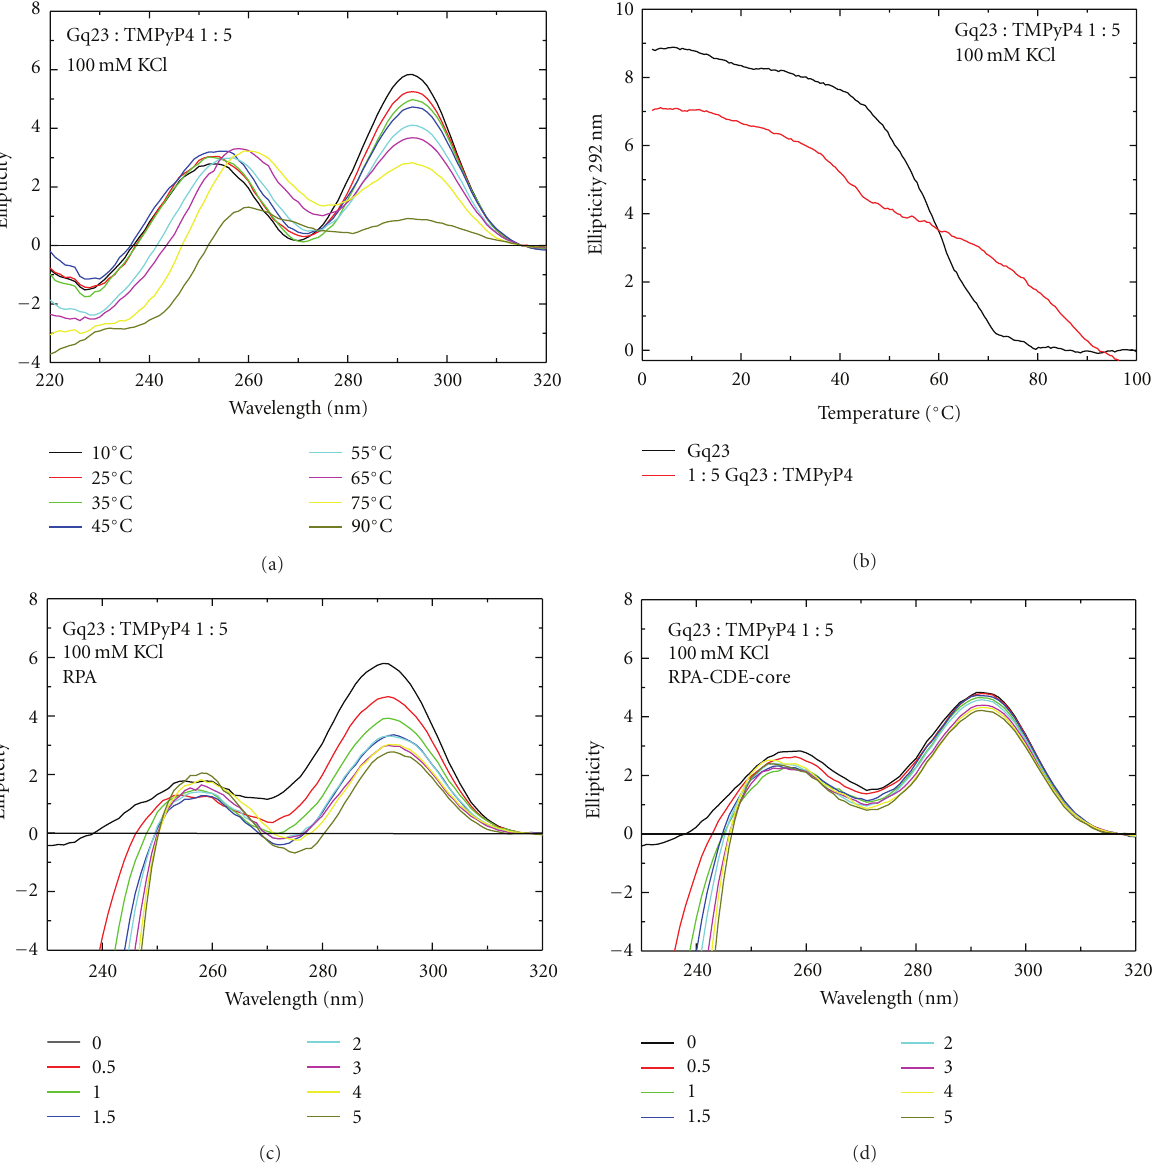
Figure 7: E ff ect of TMPyP4 and RPA on Gq23 in the presence of K + ions. (a) CD spectra of Gq23 at varying temperatures in the presence of a 1:5 molar ratio of Gq23: TMPyP4. (b) Melt at 292nm indicates thermal stabilization by TMPyP4 in 100mMKCl. (c) CD spectra of Gq23 at a 1: 5 molar ratio of Gq23 :TMPyP4 (black line). Spectra were collected upon addition of increasing molar ratios (0–5) of RPA